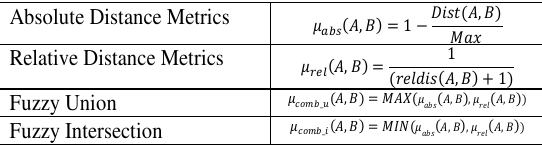
Table 1: Fuzzy distance as proposed by (Brennan and Martin, 2006)